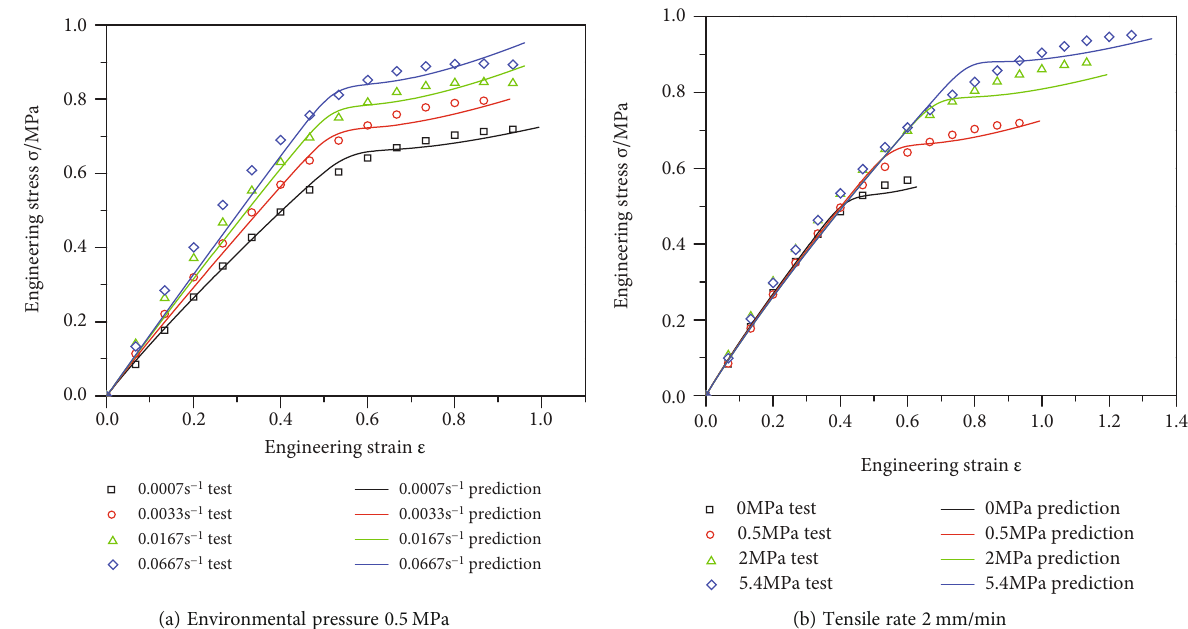
Figure 11: Comparison of the model predictions and experimental